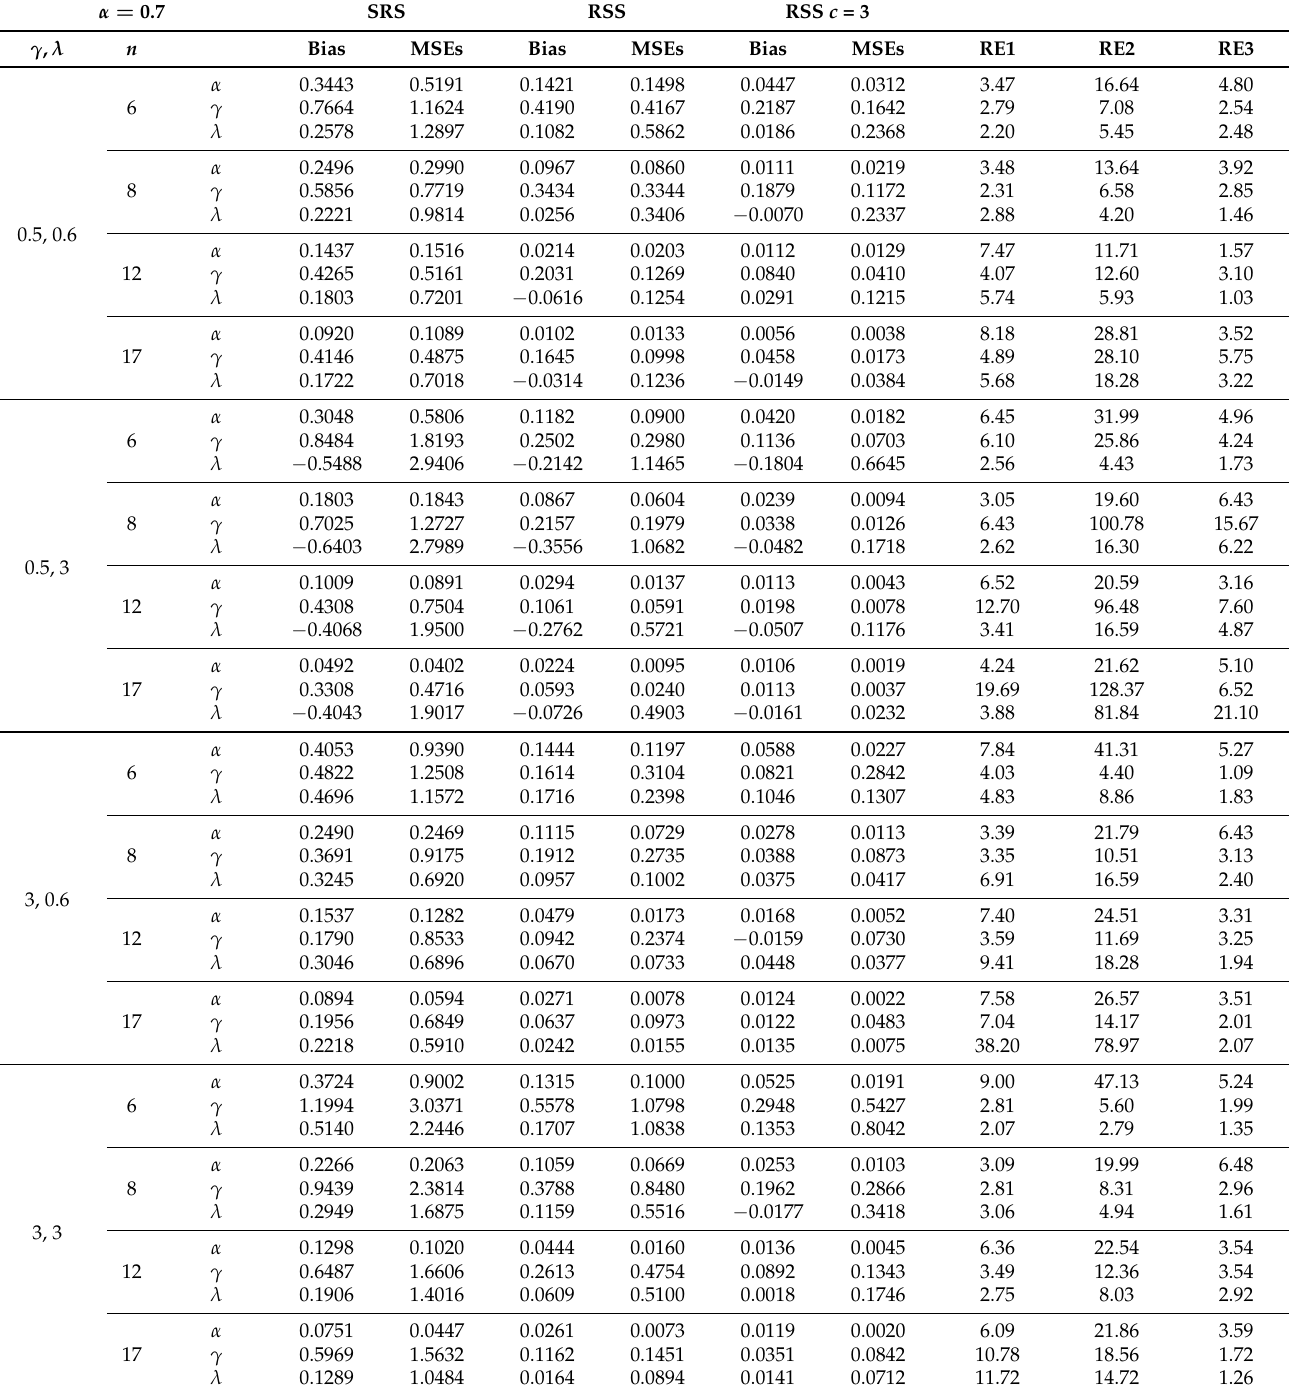
Table 5. MLE under the SRS and RSS of parameters α =